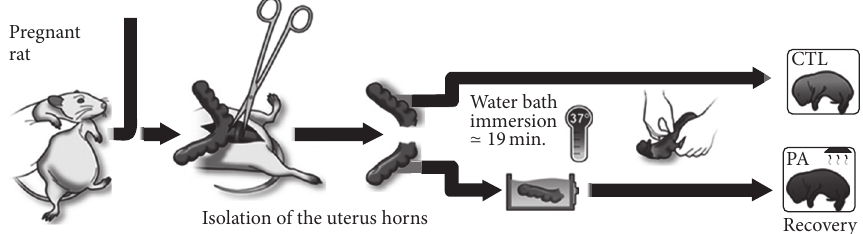
Figure 1: Illustration showing the main steps involved in the induction of PA. Adapted from